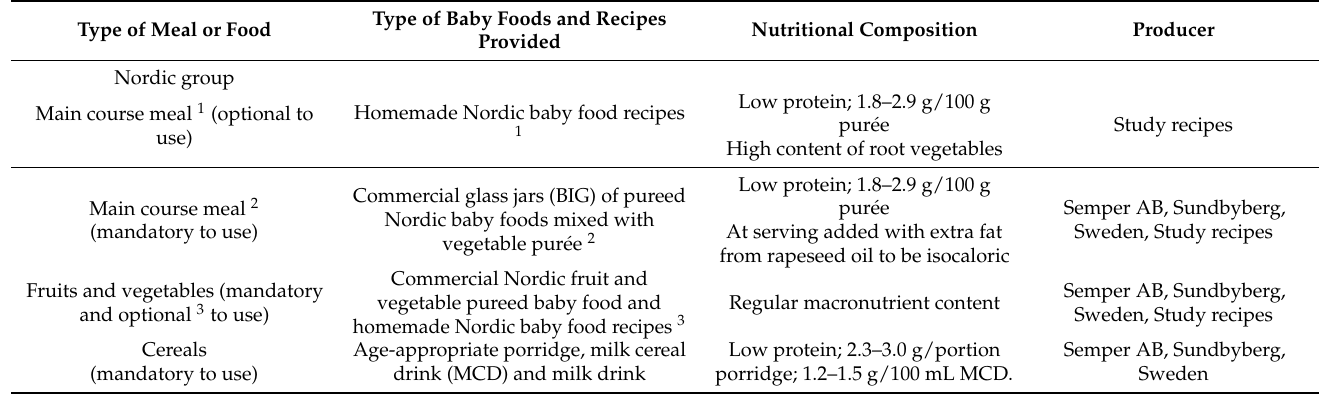
Table A1. Baby foods in the OTIS study from 6 mo to 18 mo of